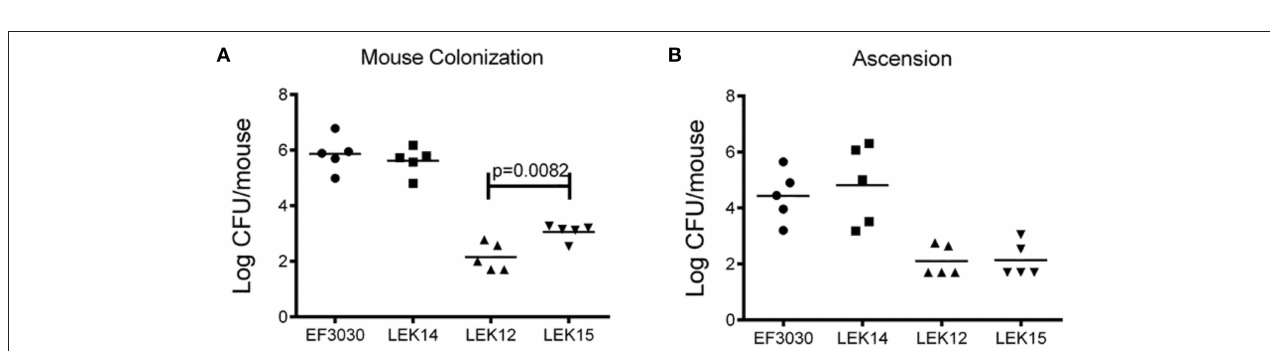
FIGURE 5 | Encapsulated strain EF3030 (serotype 19F) and mutants adherence and invasion to lung epithelial cell line A549. (A) Expression of PspK in serotype 19F EF3030 (LEK14) significantly increased epithelial cell adhesion when capsule was present ( p < 0.0001). Deletion of capsule significantly increased epithelial cell adhesion (LEK12; p < 0.0001) compared to wildtype EF3030. Expression of PspK in LEK12 (EF3030 1 cps ) did not increase adhesion of LEK15 (EF3030 1 cps ::PspK + ) compared to acapsular EF3030 (LEK12). (B) Expression of PspK in serotype 2 D39 (LEK20) significantly increased epithelial cell adhesion when capsule was present ( p = 0.034). Deletion of capsule significantly increased epithelial cell adhesion (AM1000; p < 0.0001), but expression of PspK in AM1000 (D39 1 cps ) did not increase adhesion of LEK16 (D39 1 cps ::PspK + ). (C) Expression of PspK in serotype 19F EF3030 (LEK14) significantly increased epithelial cell invasion when capsule was present ( p = 0.0024). Deletion of capsule significantly increased epithelial cell invasion (LEK12; p = 0.0149) compared to wildtype EF3030. Expression of PspK in LEK12 (EF3030 1 cps ) did not increase invasion of LEK15 (EF3030 1 cps ::PspK + ) compared to acapsular EF3030 (LEK12). (D) Expression of PspK in serotype 2 D39 (LEK20) significantly increased epithelial cell invasion when capsule was present ( p = 0.047). Deletion of capsule significantly increased epithelial cell adhesion (AM1000; p < 0.0001), but expression of PspK in AM1000 (D39 1 cps ) did not increase adhesion of LEK16 (D39 1 cps ::PspK + ). Data represents three independent experiments in triplicate.